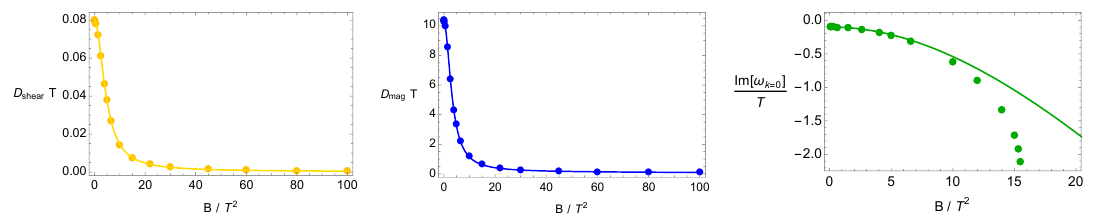
Table 3 . Approximate asymptotic behavior for the transport coefficients appearing in the disper- sion relations of the hydrodynamic modes in weak- and strong-field limits at zero density.